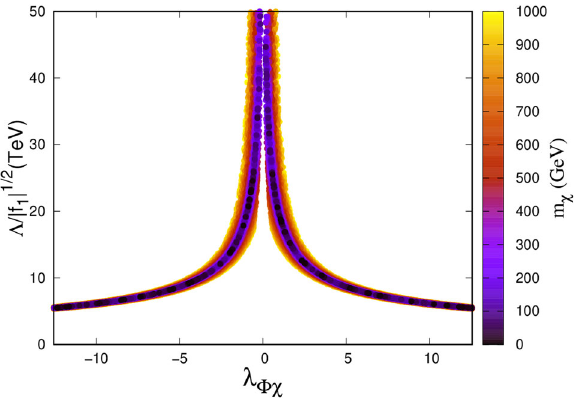
Fig. 6 Region allowed by the relic density and direct detection obser- vationintheparameterspacespannedbythecoefficientsofdimension-4 and dimension-6 operators for scalar DM. The mass of the DM has been scanned in the range 5 GeV < m χ < 1 TeV for this plot. The mass of the dark matter is shown as the color-axis